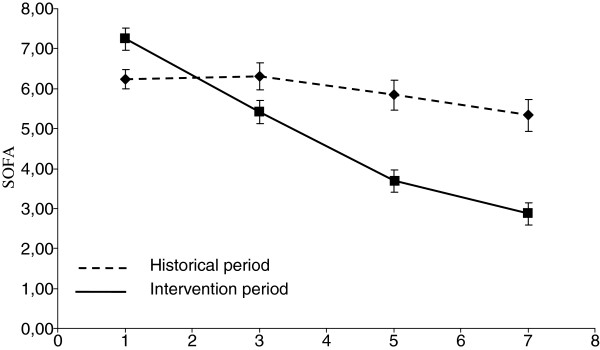
Evolution of the SOFA score during the first week following ICU admission.